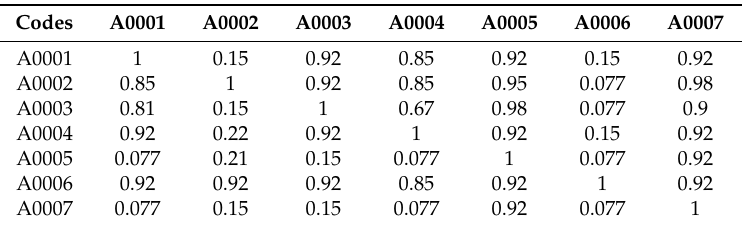
Table 6. Concordance Matrix.